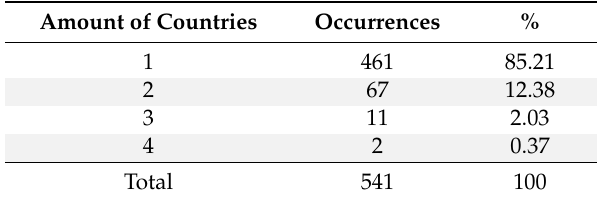
Table 11. Occurrences and amount of countries associated to each